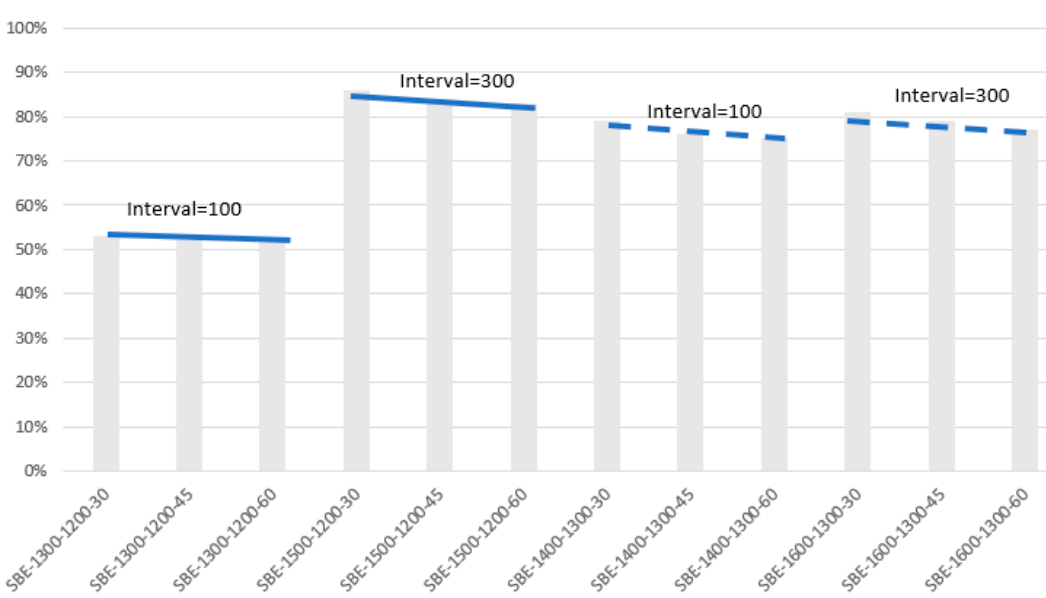
Figure 6. The overall success rate for the SBE strategy arranged by training width. Each line represents a particular elevation, with dashed lines representing 1300 m, while thick line representing 1200 m elevation.